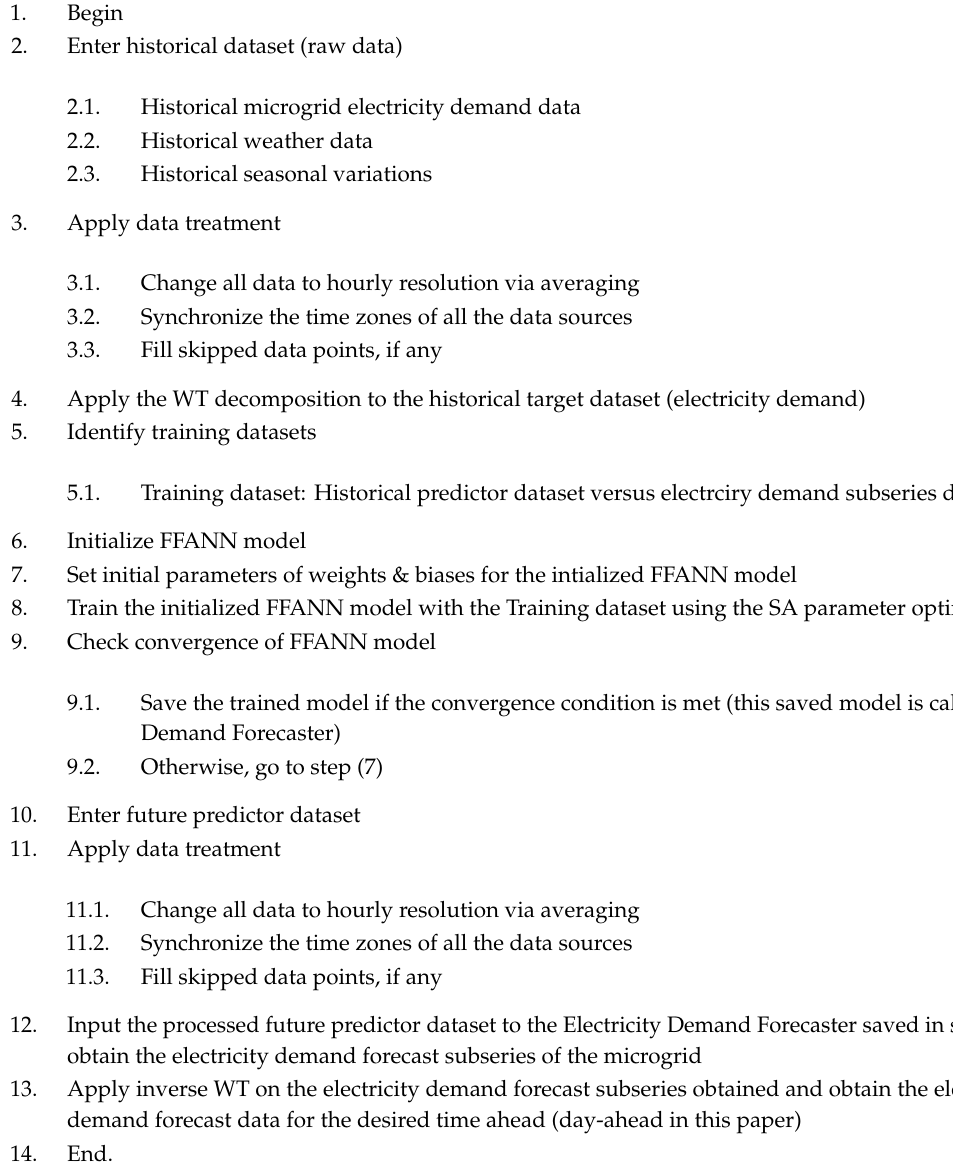
Algorithm 1 Algorithm of the proposed hybrid WT-SA-FFANN based electricity demand forecasting